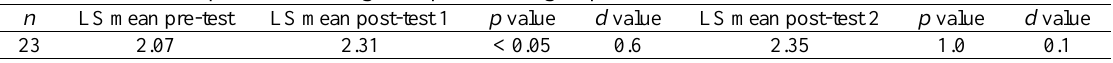
Table 5 ANOVA of problem-solving of experimental